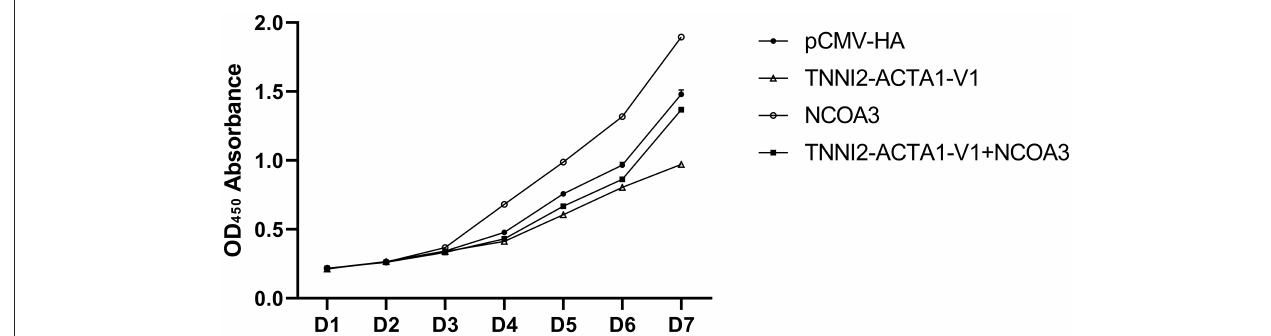
FIGURE 9 | The effects of co-transfection of TA-V1 and NCOA3 on cell viability.